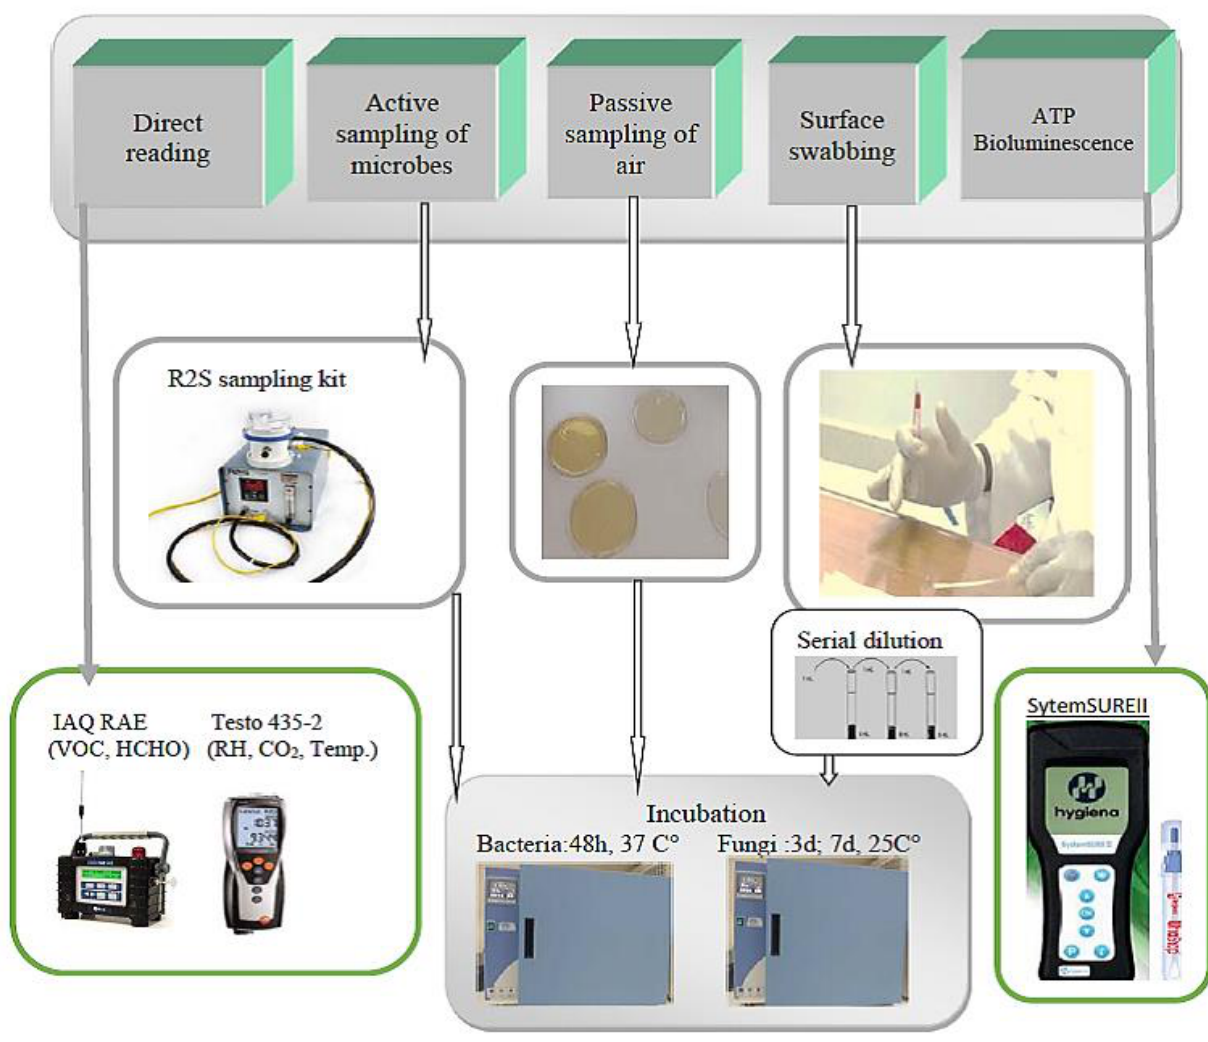
Figure 1. Study flow diagram.